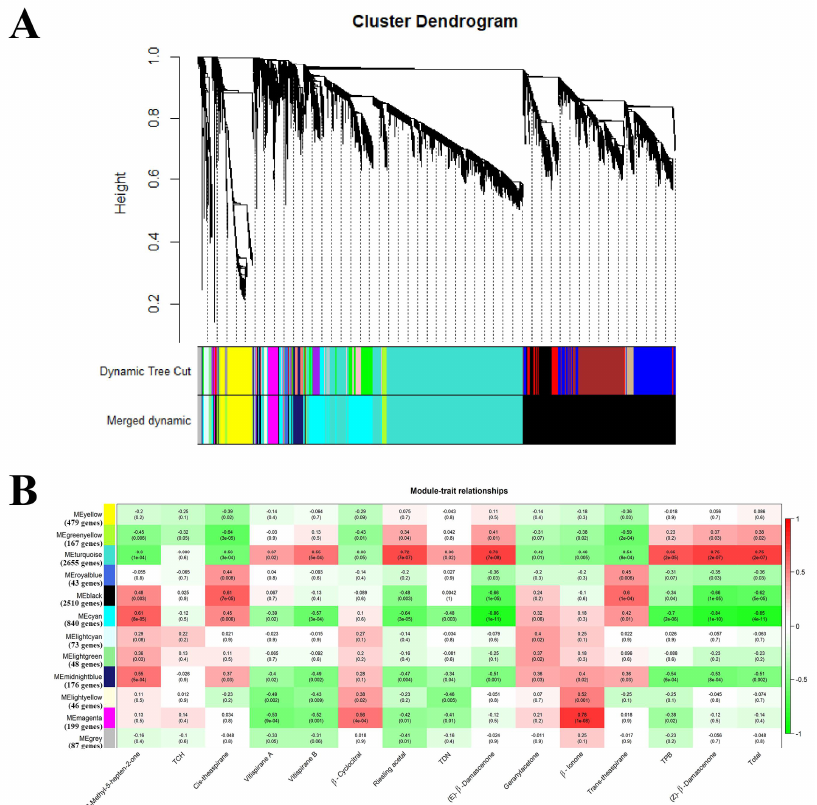
Figure 6. Weighted gene co-expression network analysis (WGCNA) of differentially expressed genes (DEGs) induced by ABA100 or NAA100 and the hierarchical cluster analysis of associated genes related to the accumulation of norisoprenoid. ( A ) Hierarchical cluster tree showing 12 merged modules of co-expressed genes. ( B ) Module-trait correlations and corresponding p -values. The left panel shows 12 modules and the right panel is a color scale for module trait correlation from −1 to 1.